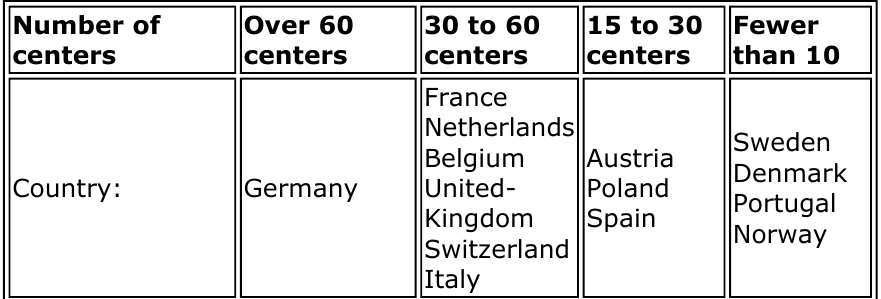
Table 1: Repartition of Zen centers in Europe